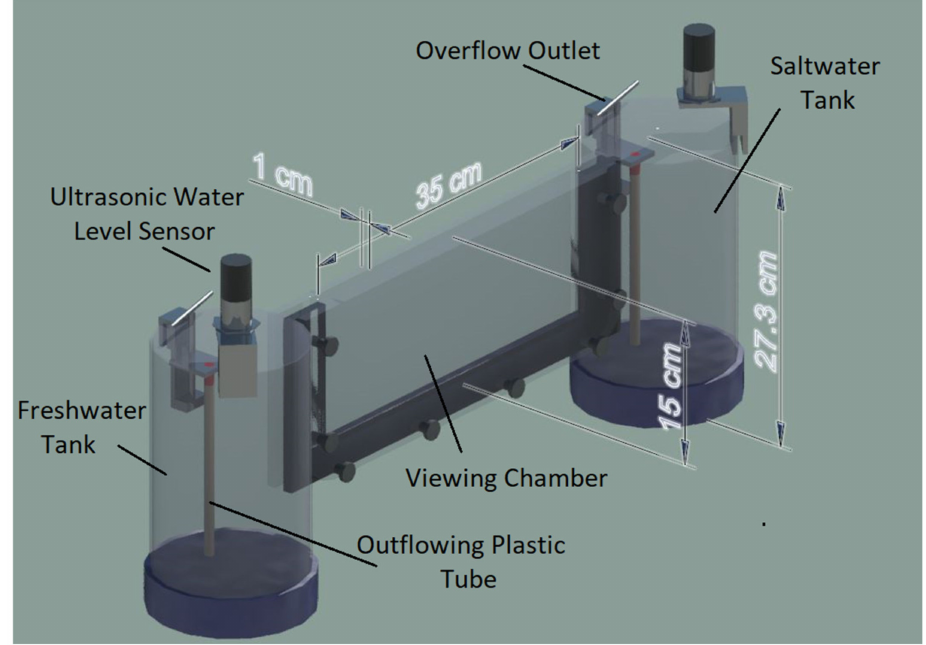
Figure 1. Three-dimensional representation of the sandbox